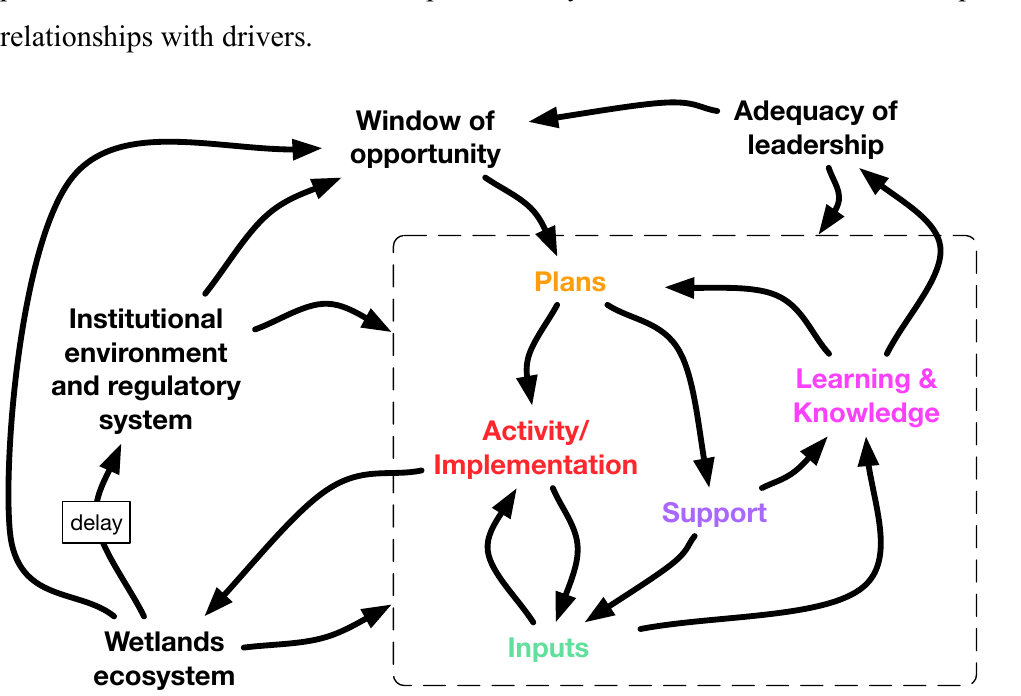
Figure 4 (from main paper). An overview level CLD, synthesising the core dynamics of studied wetland restoration initiatives in Belarus. Three sets of drivers triggered windows of opportunity and subsequently influenced five core management processes (in dashed box). Arrows connecting directly to dashed box indicate the influence of a given driver on multiple processes within the box. Figures 5 – 9 unpack the dynamics of each of the core processes and relationships with